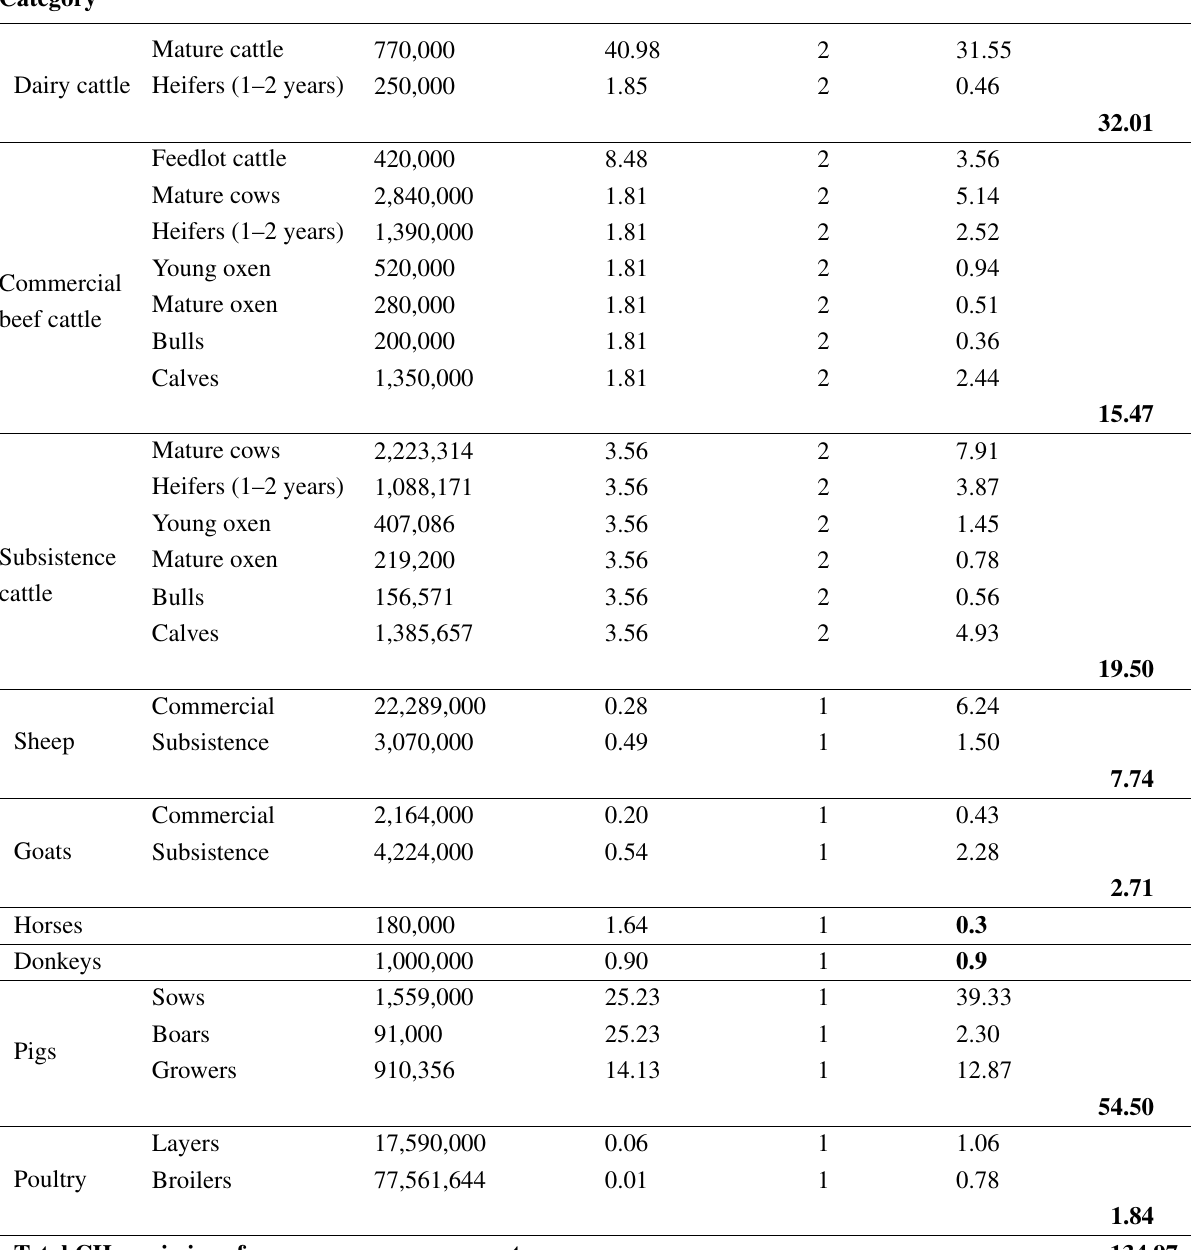
Table 5. Methane emissions from manure management (main category totals in bold).